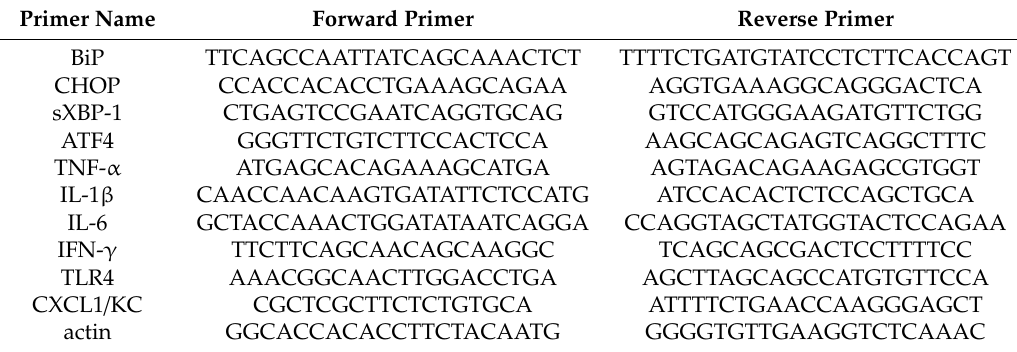
Table 2. RT-qPCR